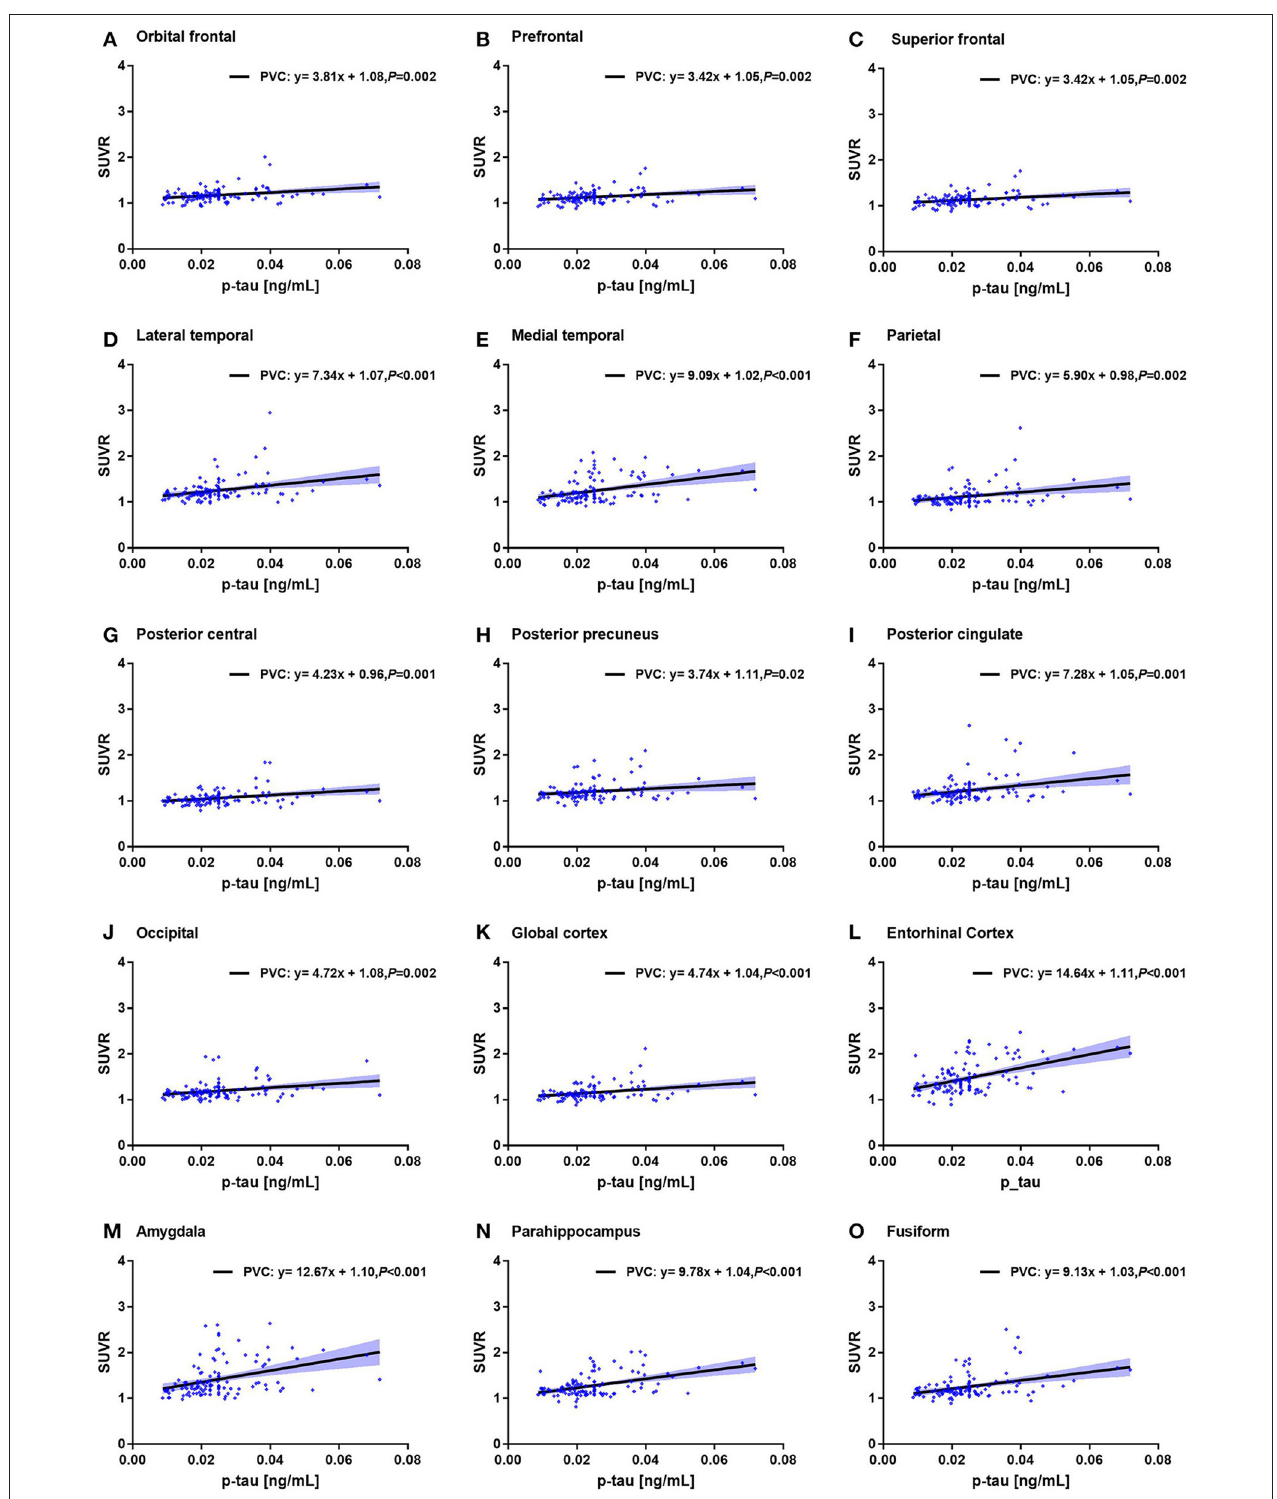
FIGURE 5 | Correlation of CSF p-tau level and 18 F-AV1451 deposition in ROI SUVRs with PVC. Correlation of CSF p-tau level and ROI SUVRs with PVC in the orbitofrontal cortex (A) , prefrontal cortex (B) , superior frontal cortex (C) , lateral temporal cortex (D) , medial temporal cortex (E) , parietal cortex (F) , posterior central cortex (G) , posterior precuneus (H) , posterior cingulate (I) , occipital cortex (J), global cortex (K) , entorhinal cortex (L) , amygdala (M) , parahippocampus (N) and fusiform (O) .